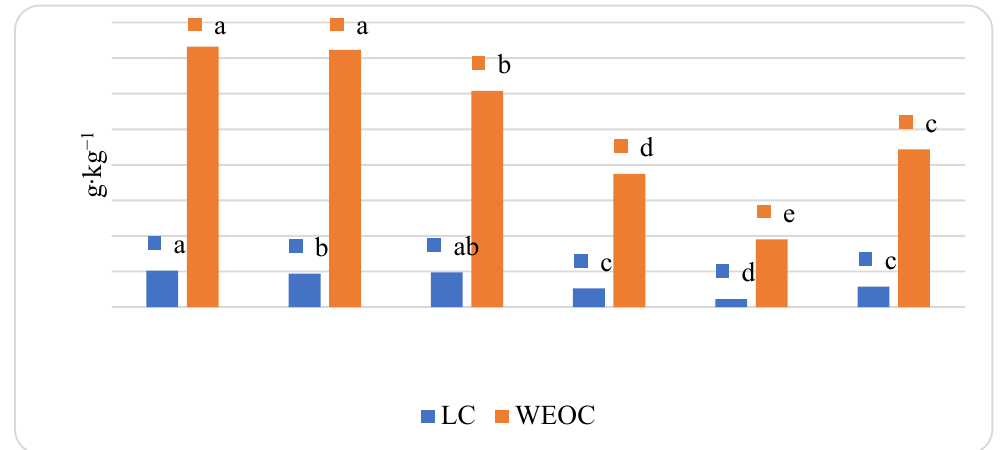
Figure 2. Contents of labile carbon (LC) and water extractable organic carbon (WEOC) in analyzed vermicomposts and composts (the same lowercase letters indicate homogeneous groups of VCs and Cs).